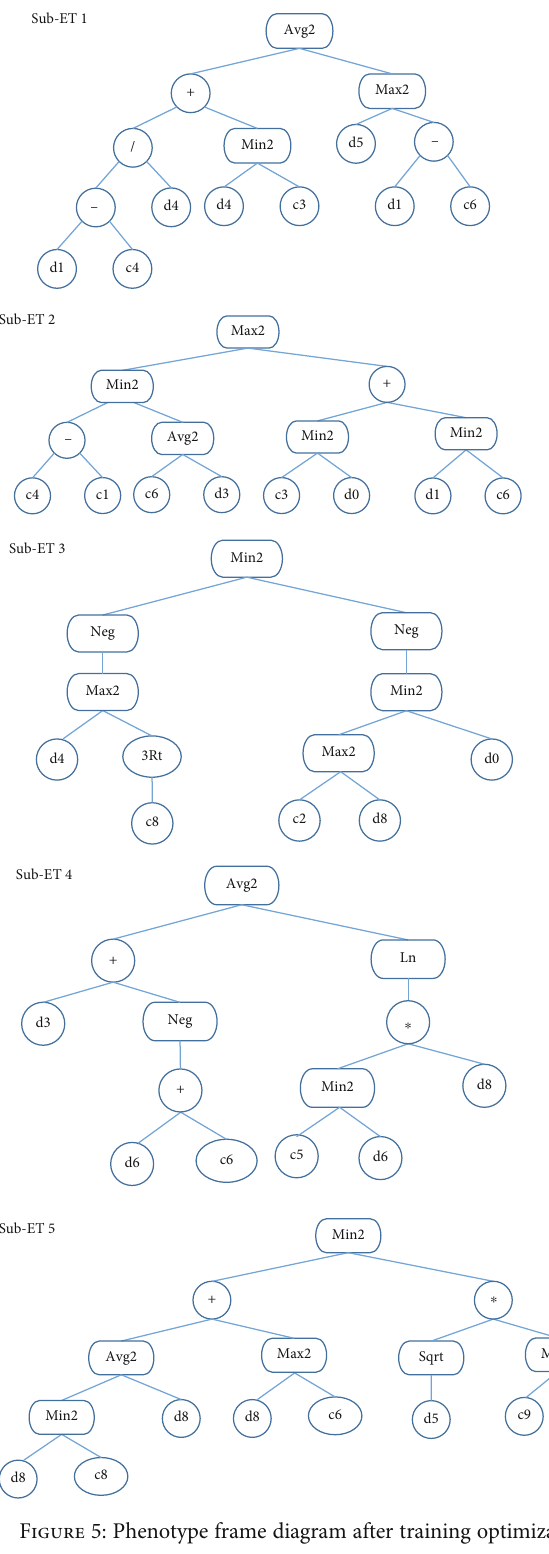
Figure 5: Phenotype frame diagram after training